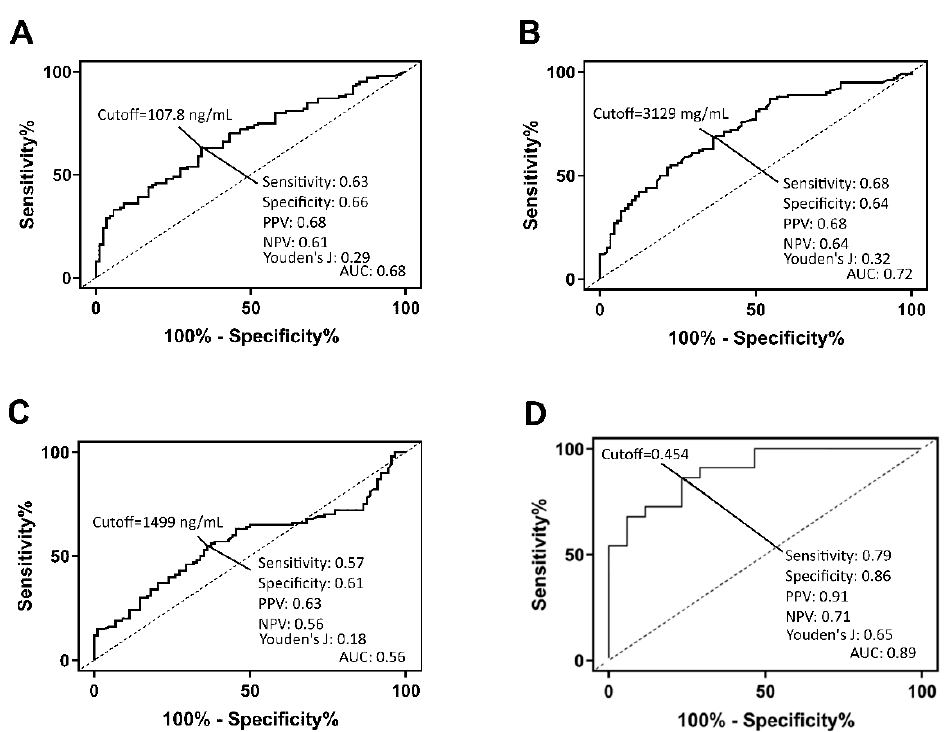
Figure 2. Receiver operating curve (ROC) generated using ( A ) KLK1, ( B ) S100A7, ( C ) CAMP and ( D ) multi-mode machine learning algorithm.